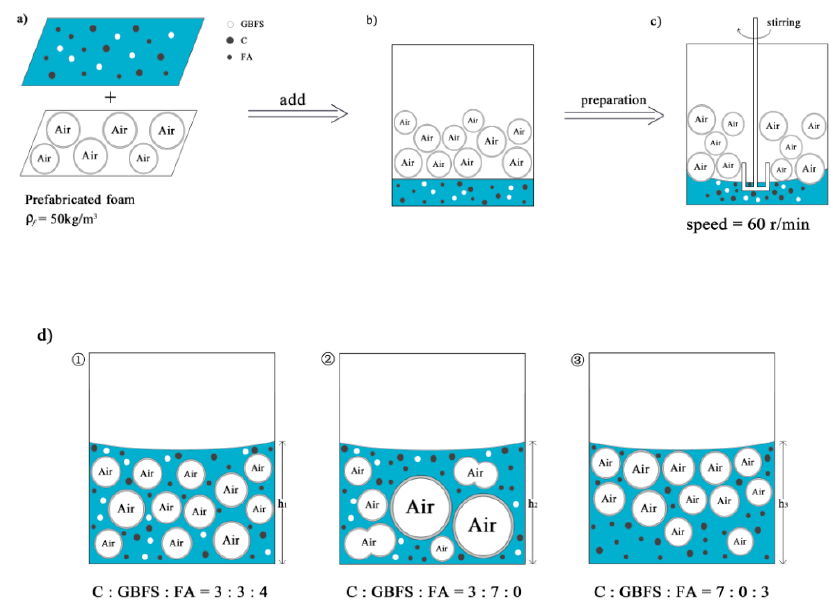
Figure 10. Theoretical mixing process of LCFLS.